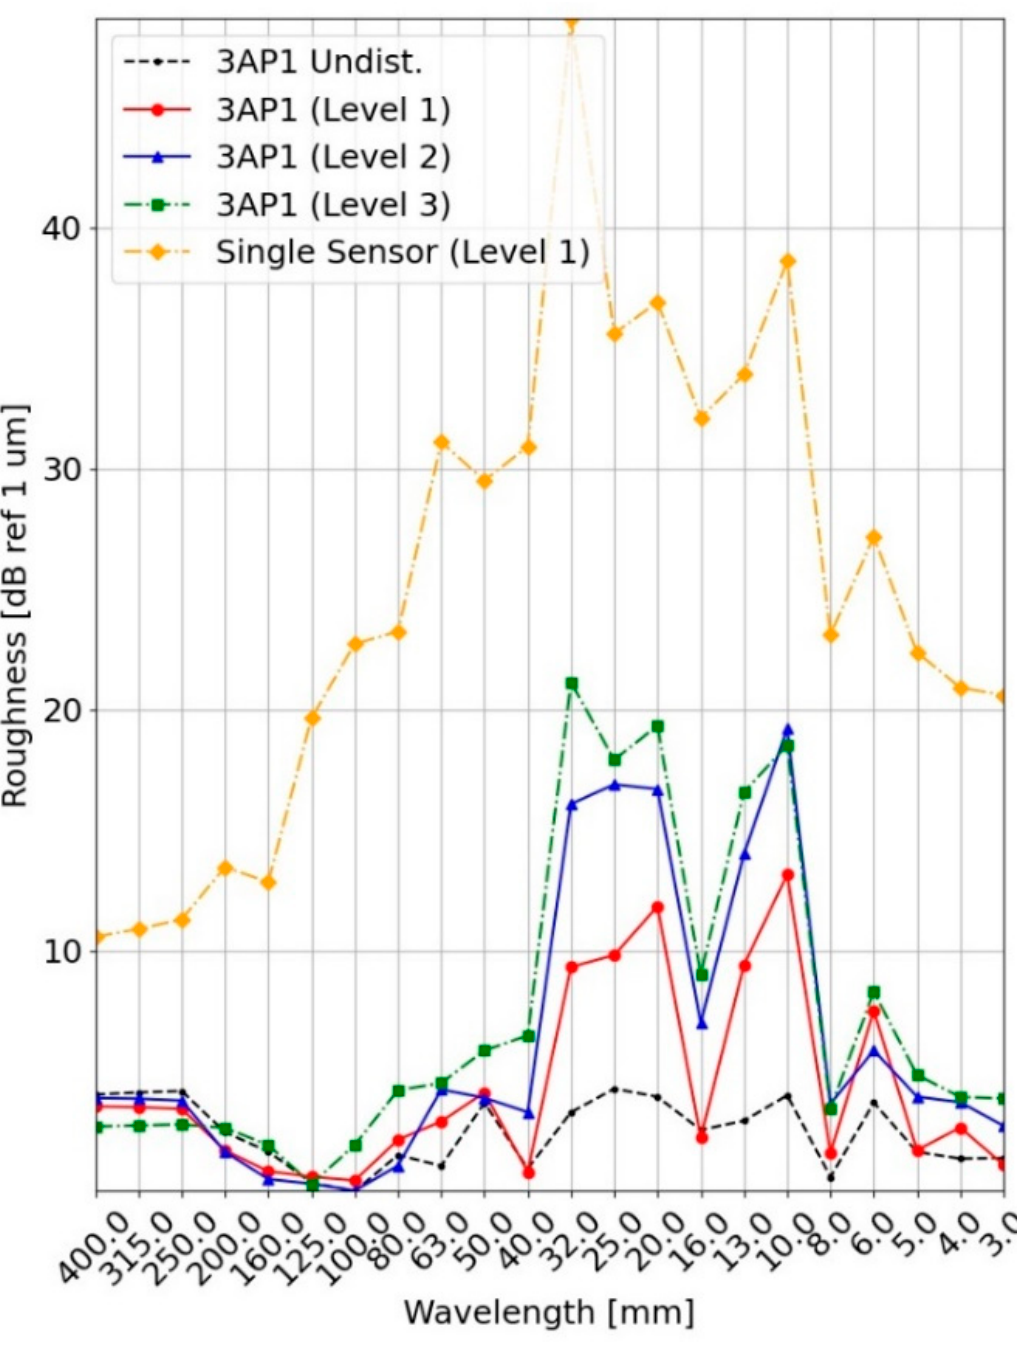
Figure 8. Absolute error of acoustic roughness for measurements with tilting of the sensor plate (amplitude indicated as levels).